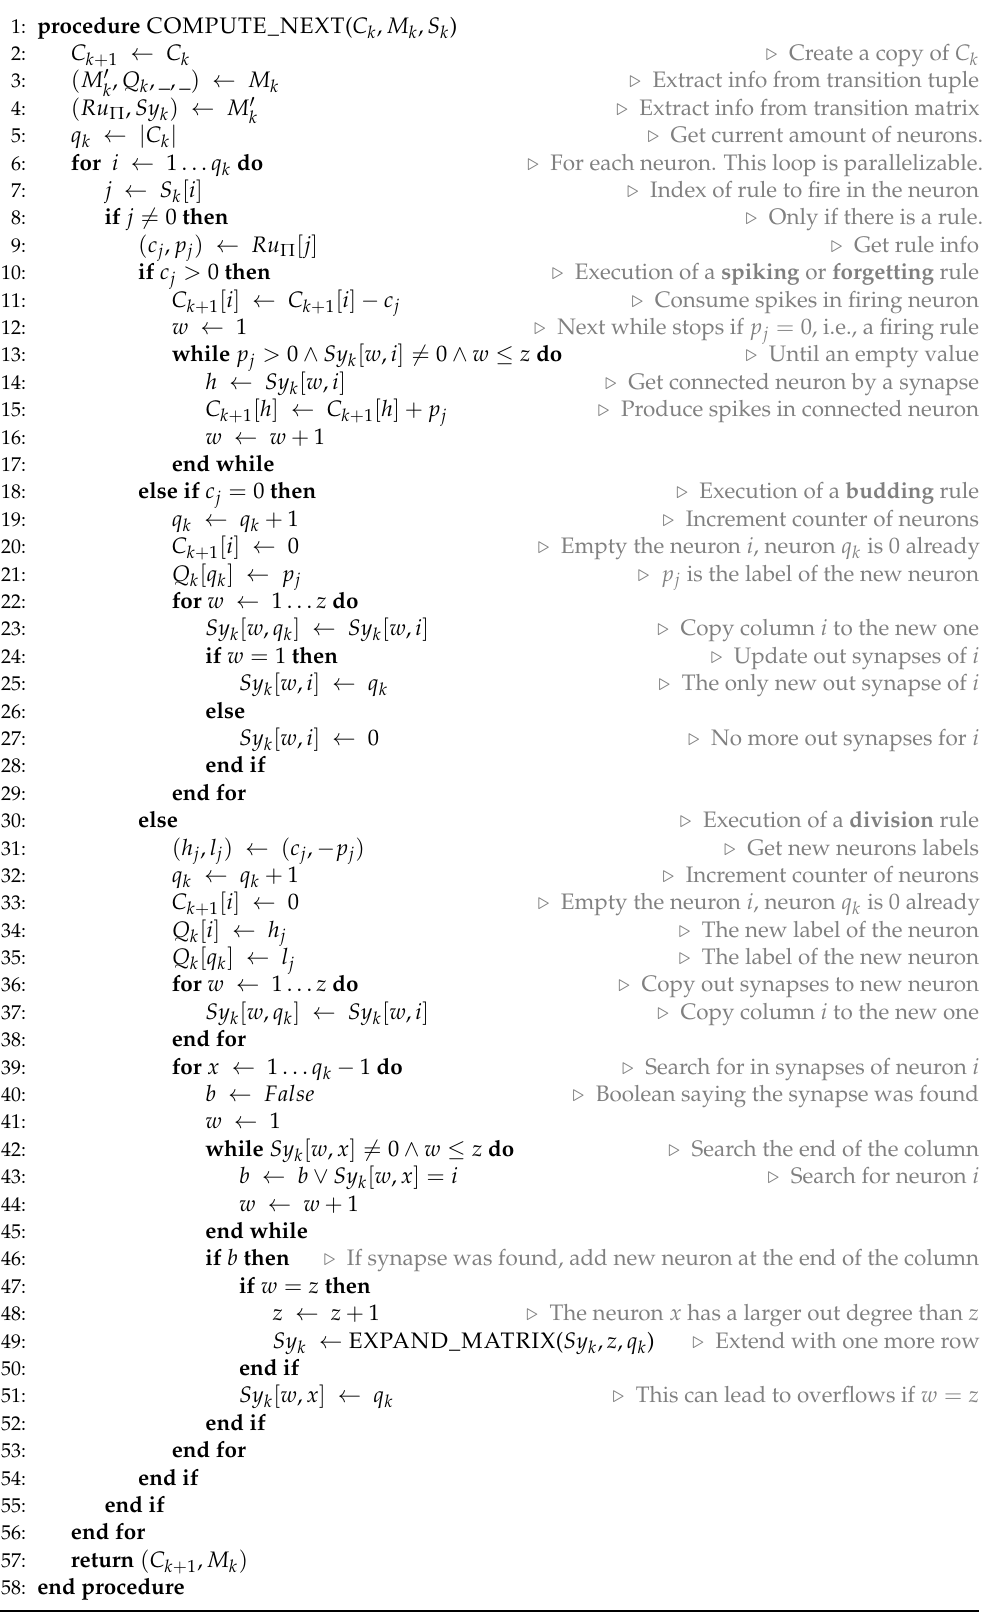
Algorithm 9 Compute next function for dynamic SNP systems with budding and division rules using optimized compressed matrix